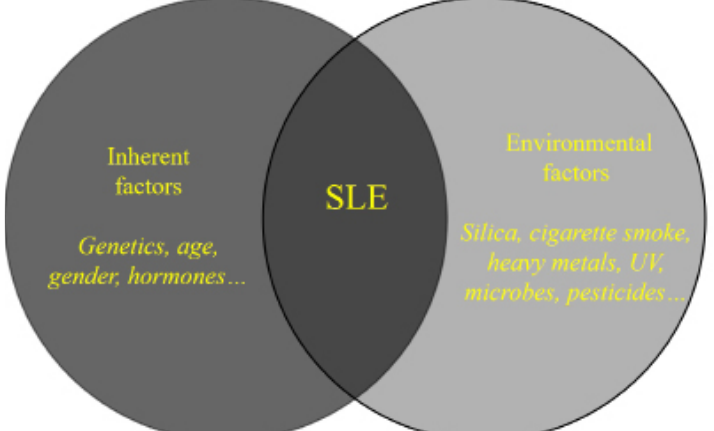
Figure 1. A complex interaction between inherent and environmental factors is believed to contribute to the onset of SLE in most instances. UV: ultraviolet